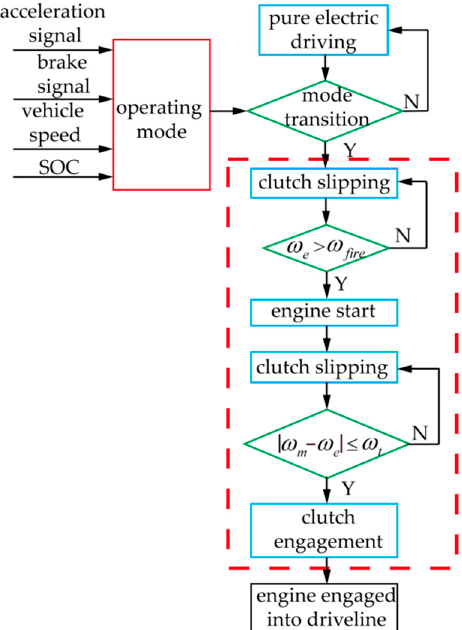
Figure 4. Flow chart of the mode transition from EM driving to engine driving.